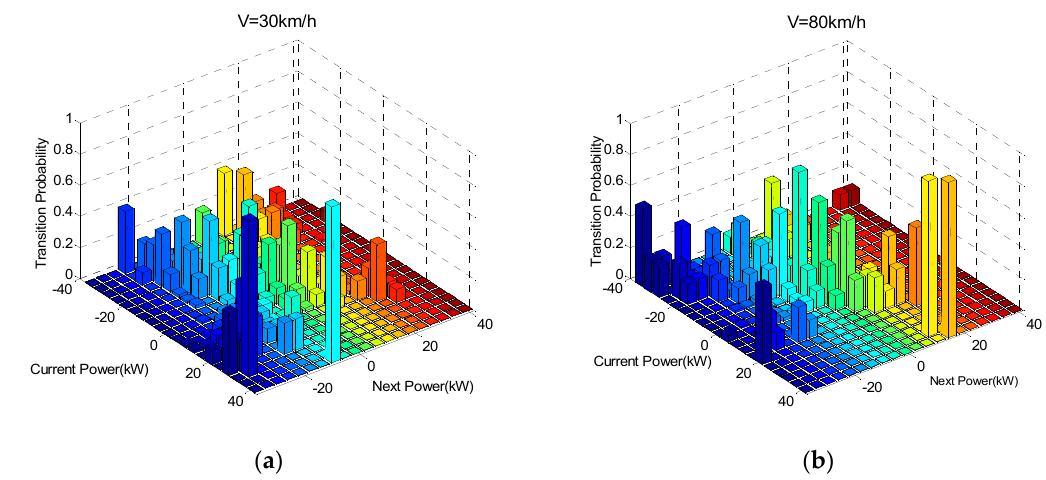
Figure 4. The transition probability map. ( a ) The transition probability map at V = 30 km/h; ( b ) The transition probability map at V = 80 km/h.